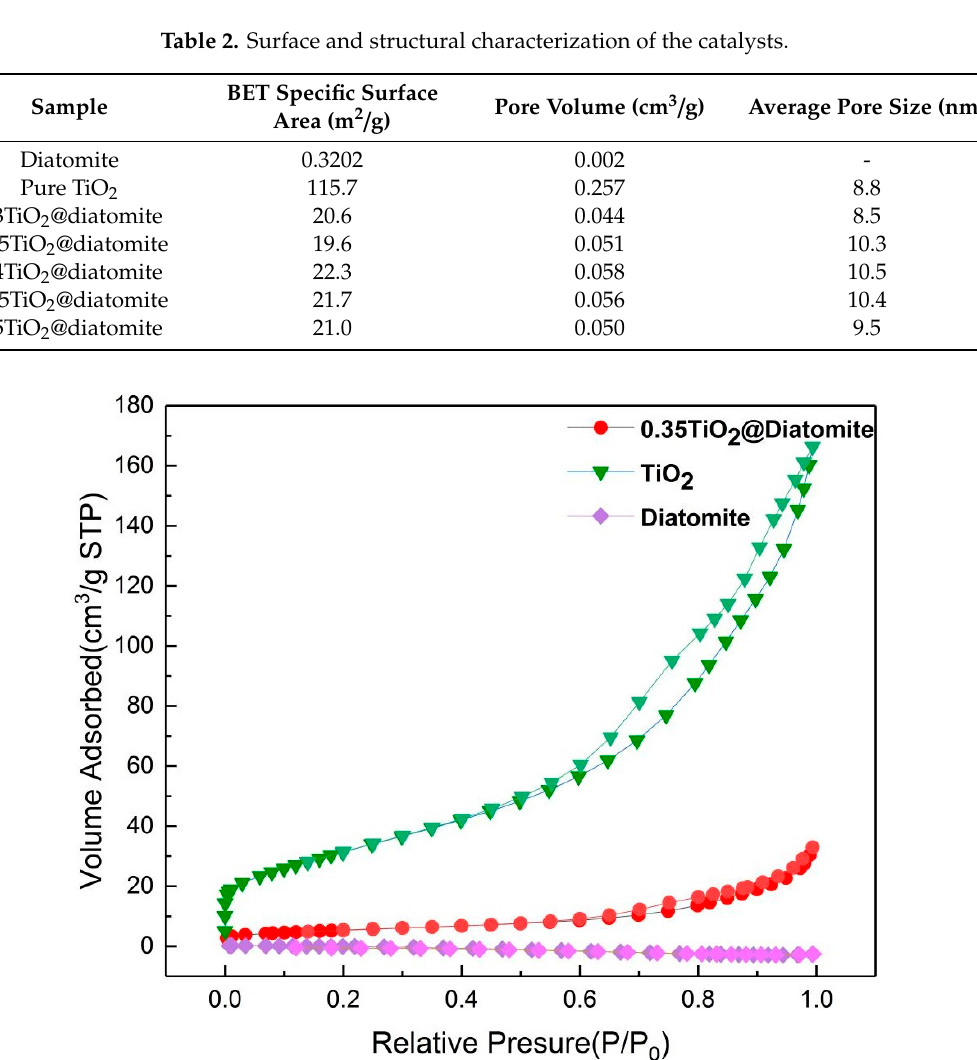
Figure 5. N 2 adsorption-desorption isotherms of diatomite, TiO 2 , and 0.35TiO 2 @diatomite.